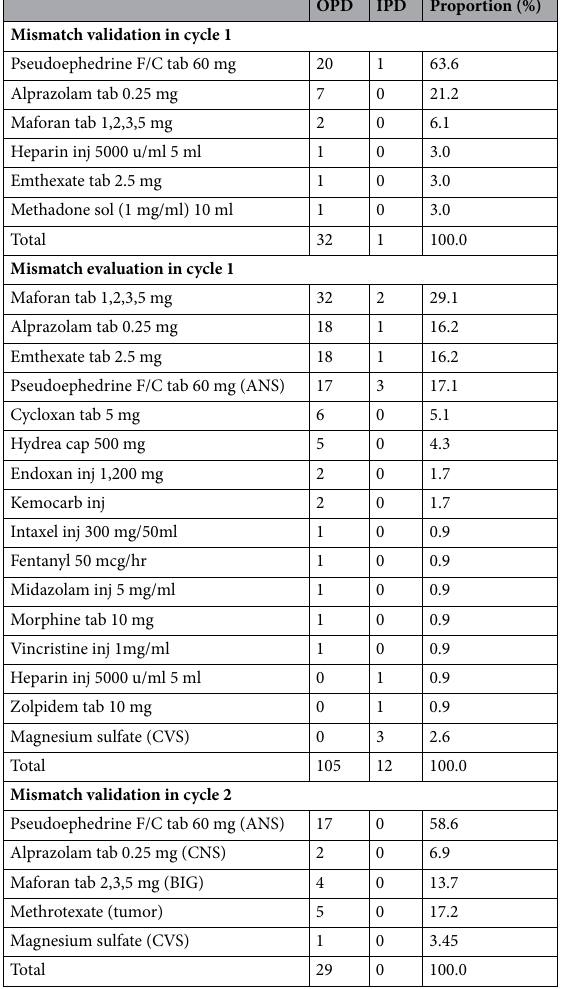
Table 12. HAD–ICD10